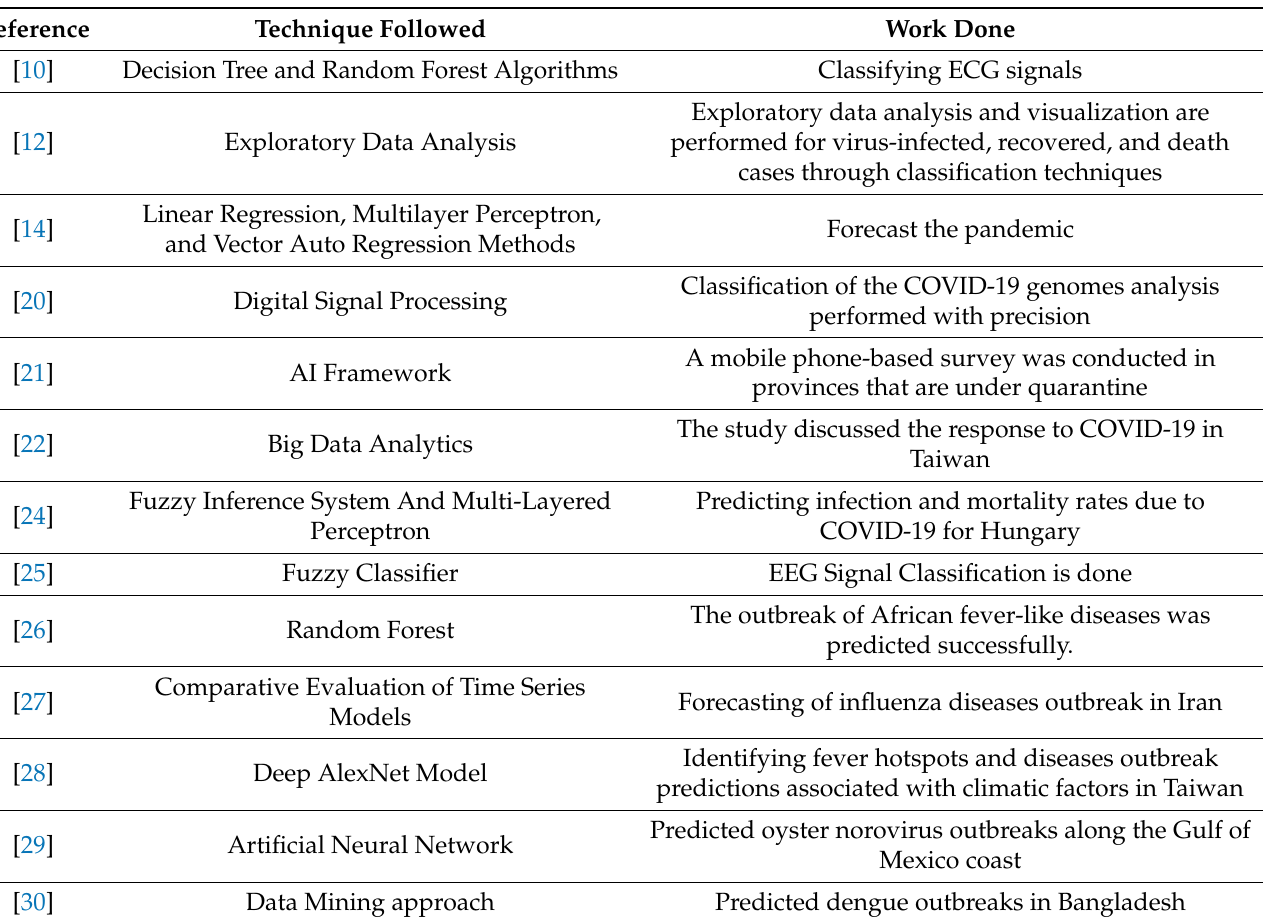
Table 1. The various Machine Learning models in COVID-19